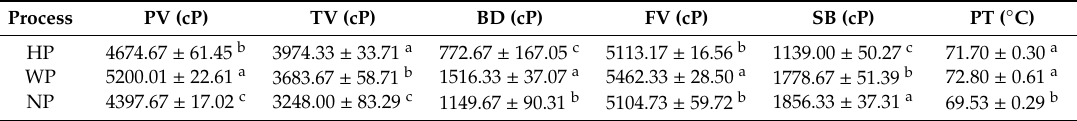
Table 4. Pasting characteristics of djulis starch by the three treatment